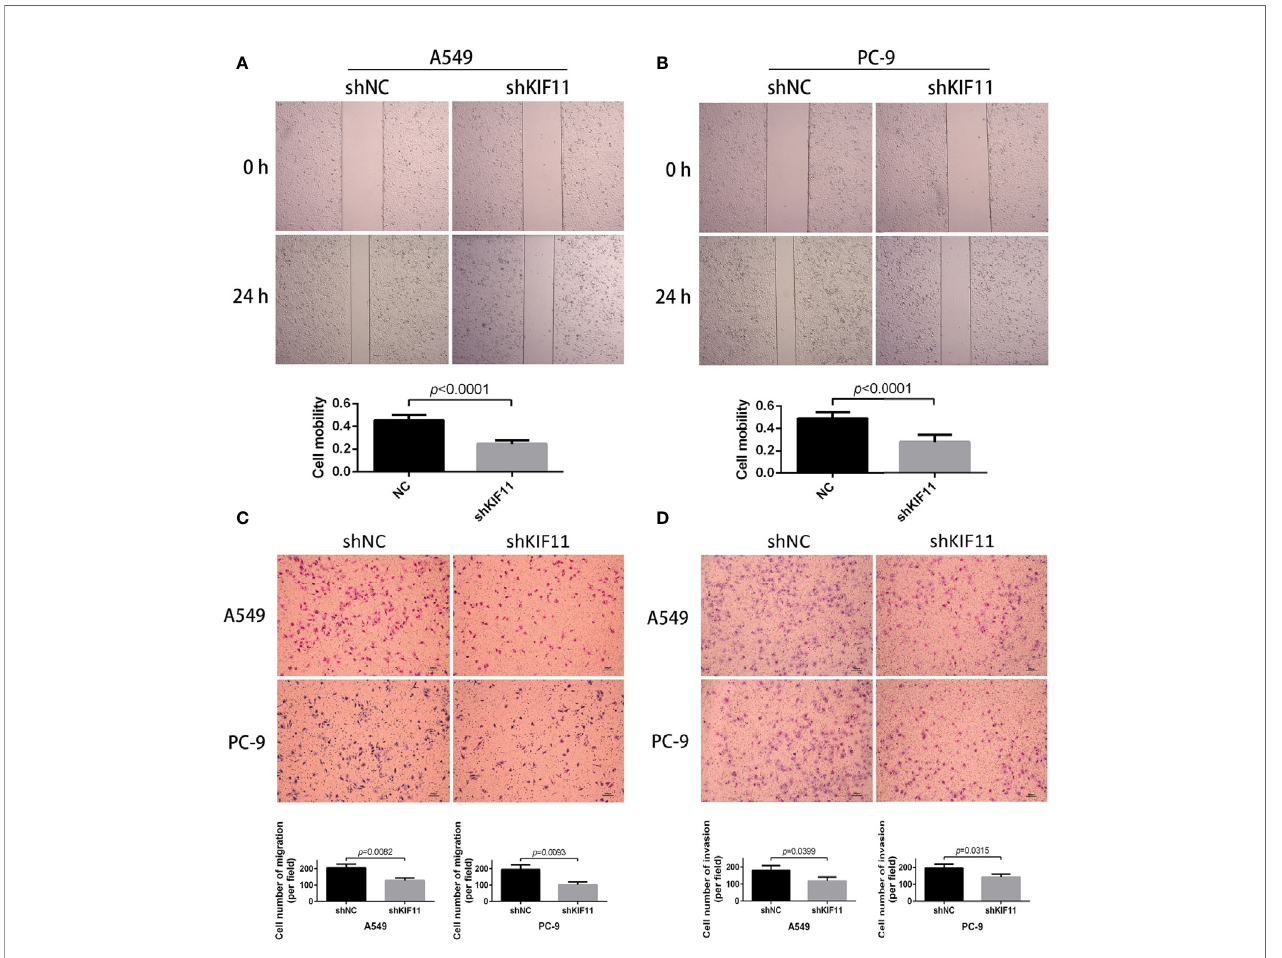
FIGURE 10 | KIF11 knockdown inhibited the migration and invasion of LUAD cells. Wound healing assay revealing that KIF11 knockdown reduced the migration capability of (A) A549 and (B) PC-9 cells after 24 h transfection. Transwell assay showing that KIF11 knockdown decreased (C) migration and (D) invasion of A549 and PC-9 cells after 24 h